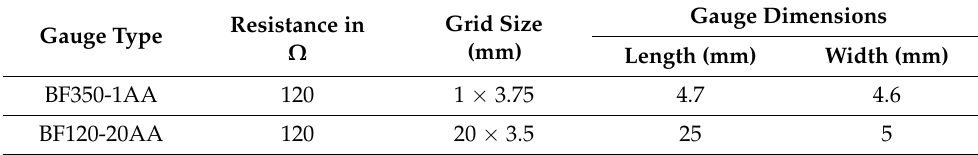
Table 7. The test results of the three tested slabs.